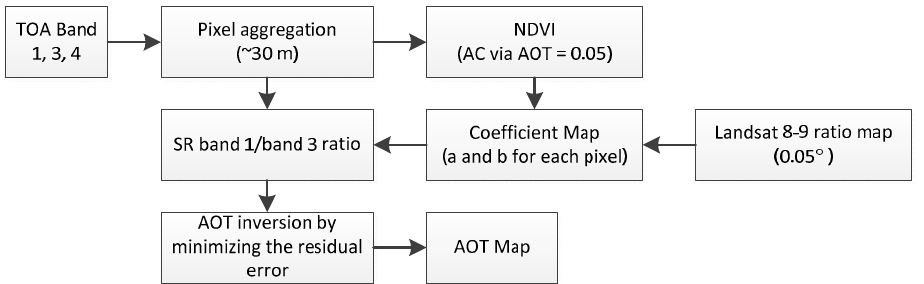
Figure 2. AOT inversion scheme for the optical data with 4 bands.